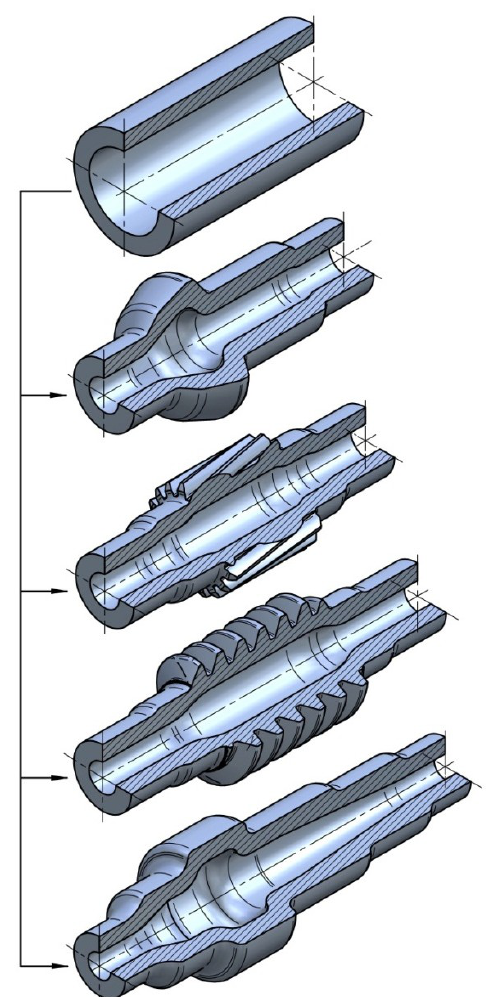
Figure 2. Examples of forgings that can be manufactured by rotational compression.